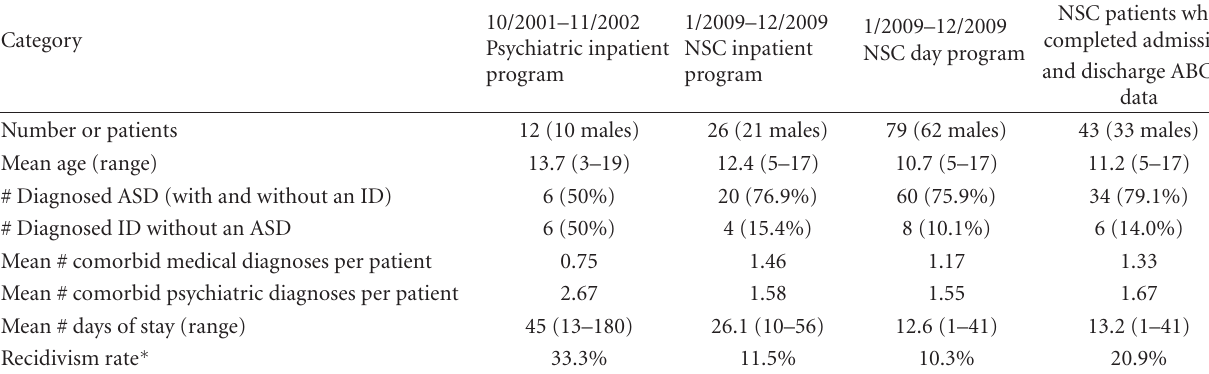
Table 1: Demographics and outcome